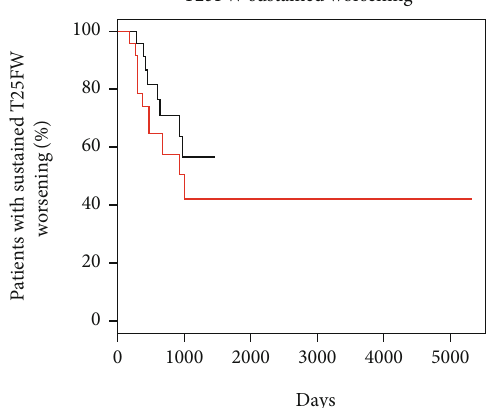
Figure 3: Kaplan-Meier curve of the time to sustained worsening on timed 25-foot walk (T25FW). Red line represents glatiramer acetate; black line represents teri fl unomide. y -axis is the probability of remaining free of sustained progression on T25FW, and the x -axis is the days since treatment